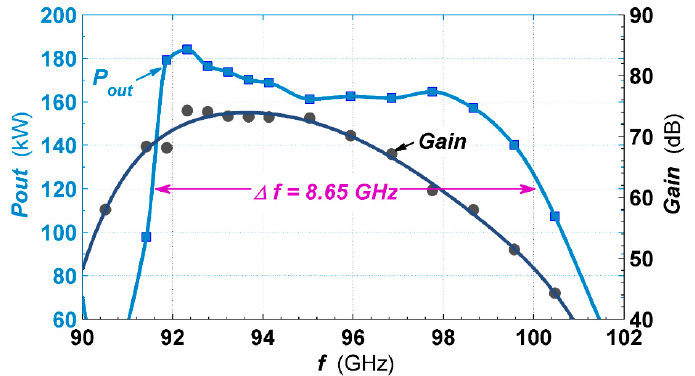
Figure 6. Calculated bandwidth of the W-band TE 02 mode gyro-TWT.